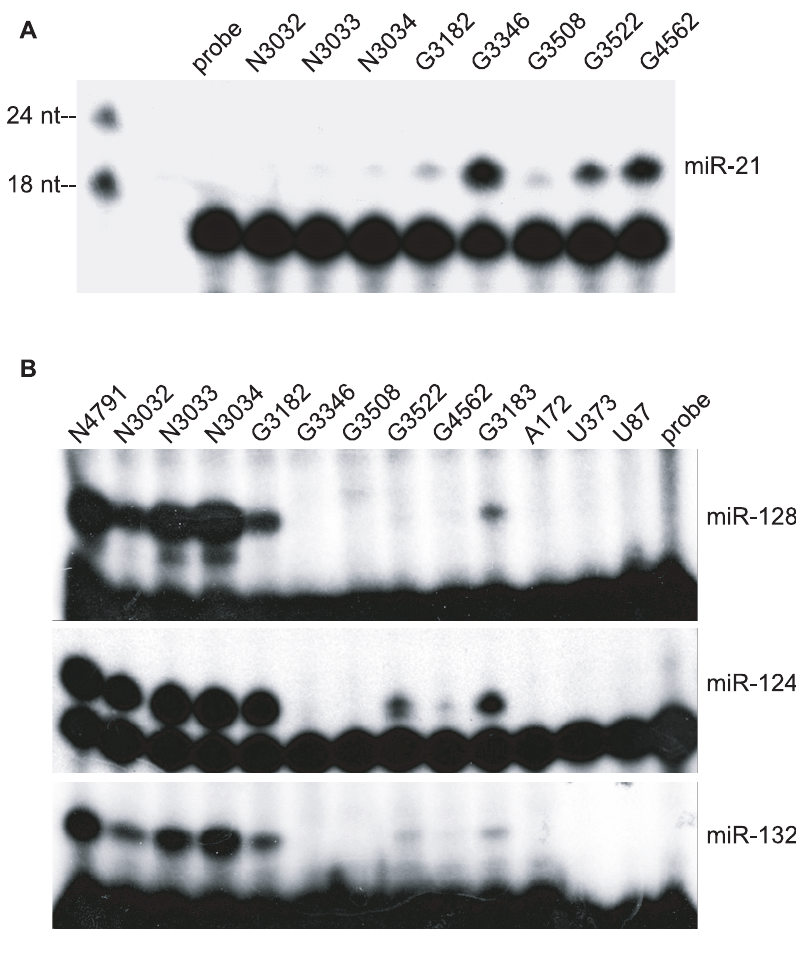
Figure 2. MiRNA expression in brain tissue samples and glioblastoma cell lines. A. miR-21 expression detected by primer extension. B. miR- 128, miR-124, and miR-132 expression levels detected by primer extension. N = non-tumor brain tissue. G = glioblastoma. A172, U373, and U87 are glioblastoma cell lines. 6 m g total RNA were used for each reaction. Free probe is shown as a negative control for each miRNA assayed. Primer extension reactions were resolved on 15% TBE-Urea polyacrylamide gels and exposed to film for either 1 hr (miR-21) or overnight (miR-128, miR-124, miR-132).